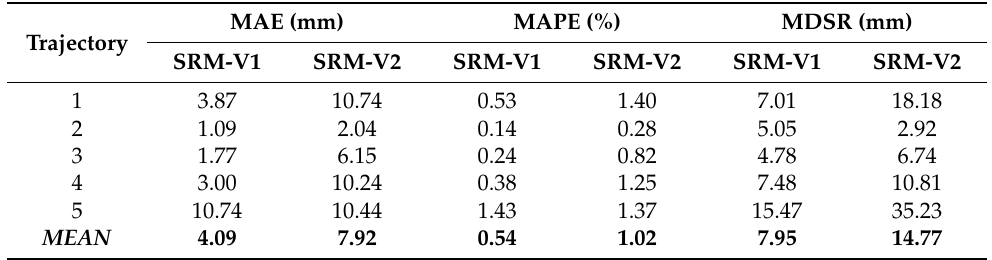
Table 4. Performance of the hybrid controller using SRM-V1 and SRM-V2 in the simulation.